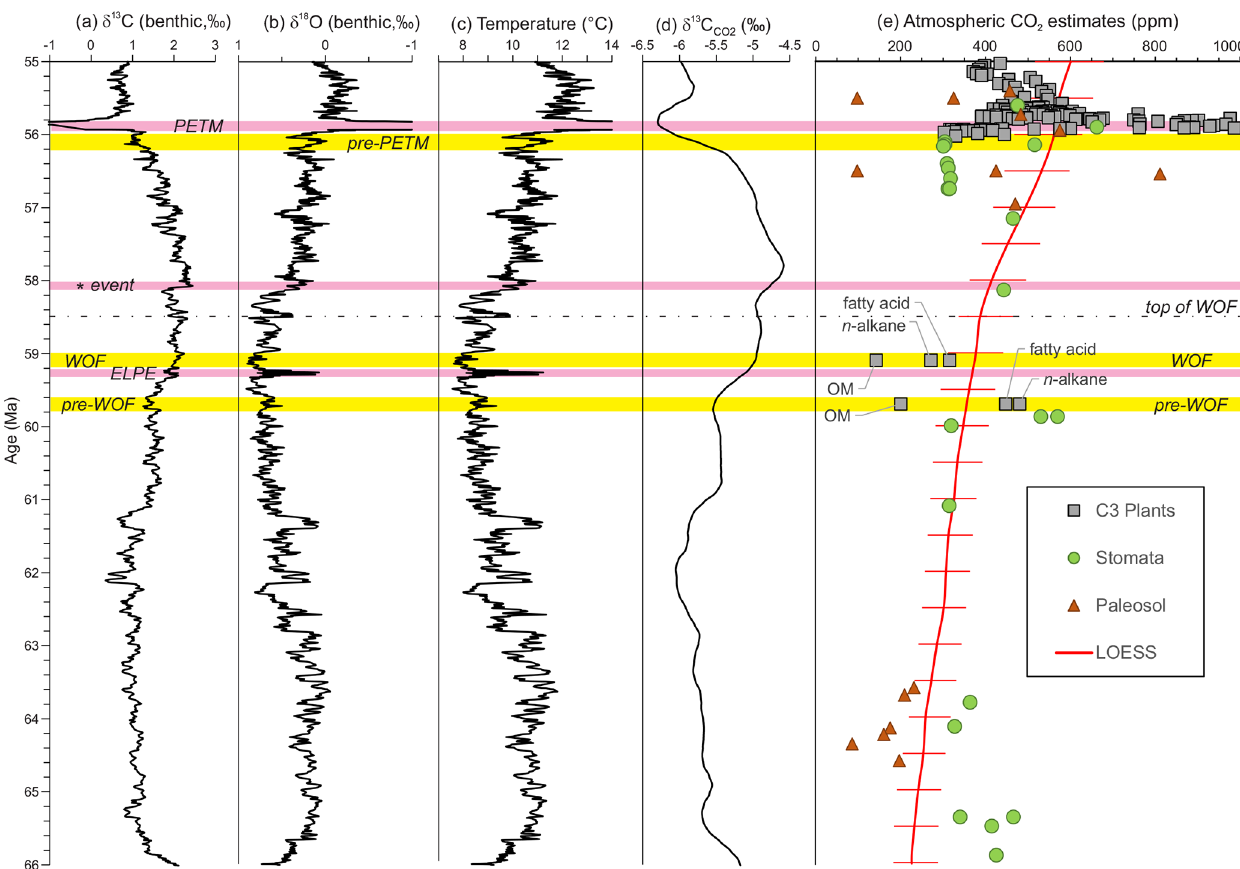
Figure 14. Compilation of early Paleogene variation in deep-sea benthic foraminiferal (a) carbon and (b) oxygen isotopes (LOESS smoothed curves from Westerhold et al., 2020), (c) oxygen isotope-based temperatures, (d) carbon isotope values for atmospheric CO 2 and (e) estimates for atmospheric CO 2 volume (Hollis et al., 2019; after Foster et al., 2017). Horizontal pink bands – hyperthermals or carbon isotope excursion; horizontal yellow bands – reference time slices for CO 2 determinations; WOF indicates Waipawa